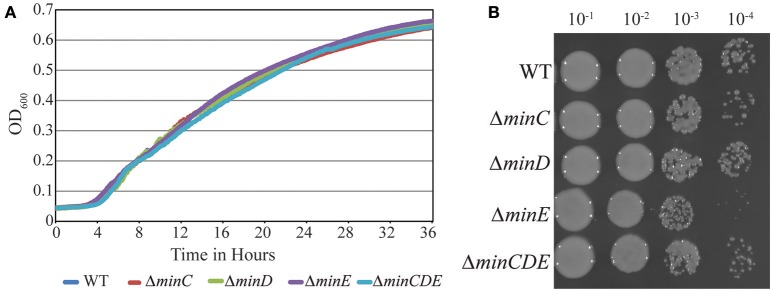
Growth and viability of min mutants is not compromised. (A) Growth of Wildtype A. tumefaciens strain C58 and min mutants is monitored over 36 h by observing the increase in optical density. (B) Exponentially growing cells were diluted to OD 600 = 0.05 and serial dilutions were spotted on nutrient rich medium to observe viability.